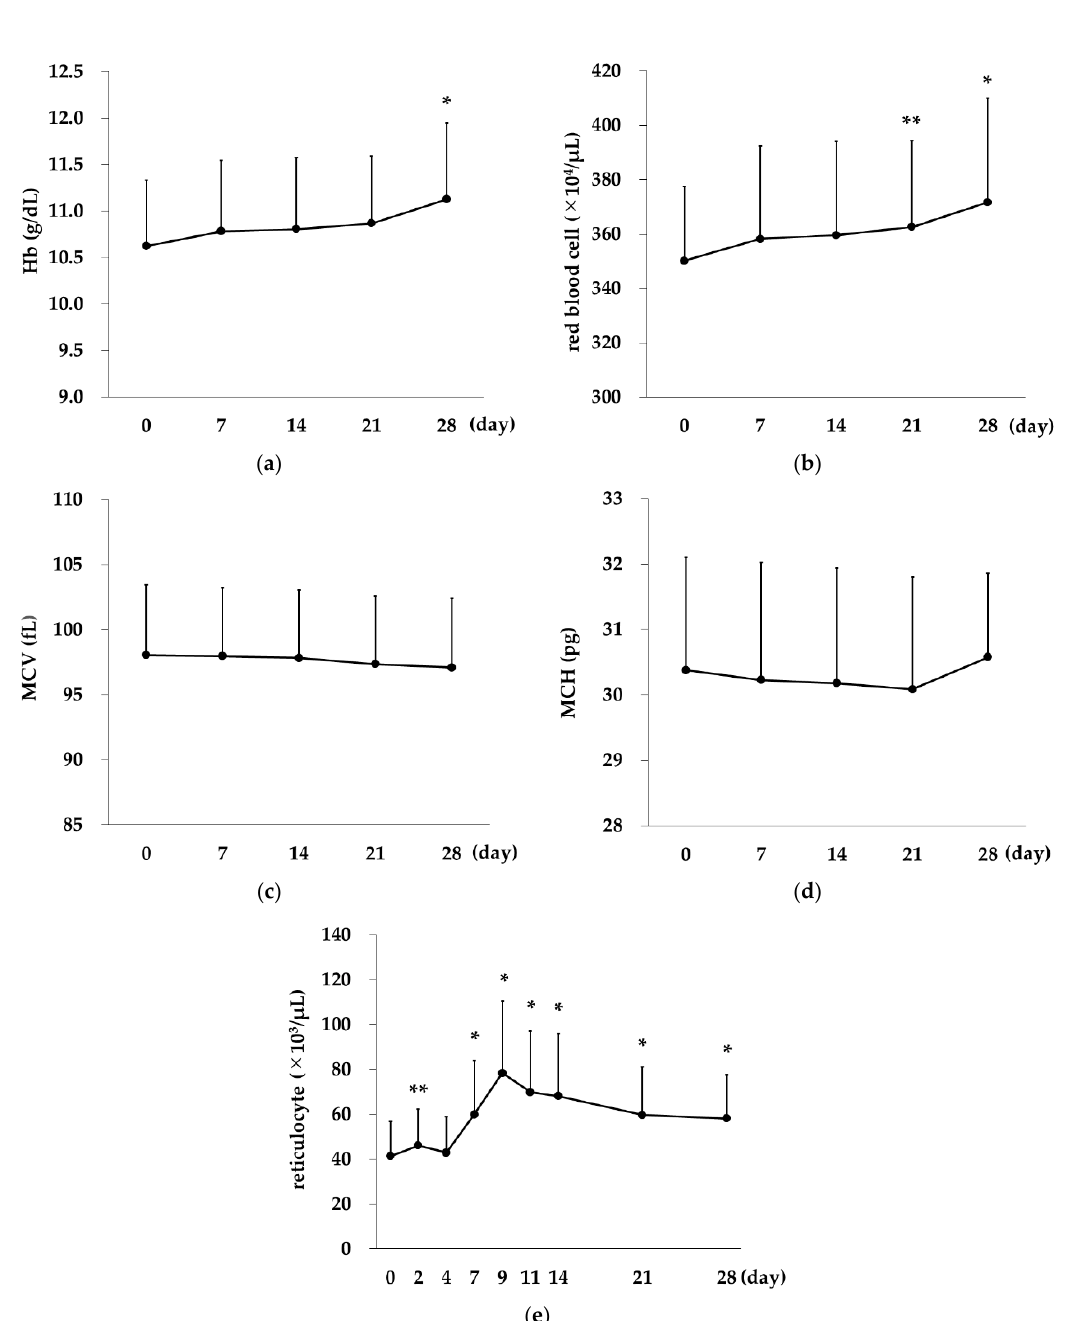
Figure 3. Correlation between reticulocytes and red blood cell counts. ( a ) Ret count on Day 9 and RBC count on Day28: Ret and RBC counts showed a significant positive correlation ( r = 0.005 [95%CI: 0.000 to 0.009; p = 0.04]). ( b ) Increase of Ret count from day 0 to day 9 and that of RBC count from day 0 to day 28: Increase of Ret and RBC counts showed a significant positive correlation ( r = 0.005 [95%CI: 0.002 to 0.008; p = 0.001]). Pearson product-moment correlation coefficient and univariable linear regression model were used.